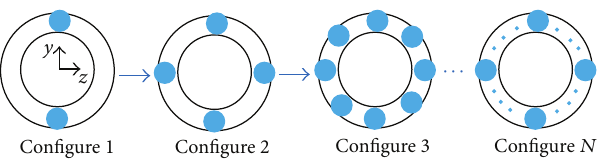
Figure 21: Configurations of piezoelectric